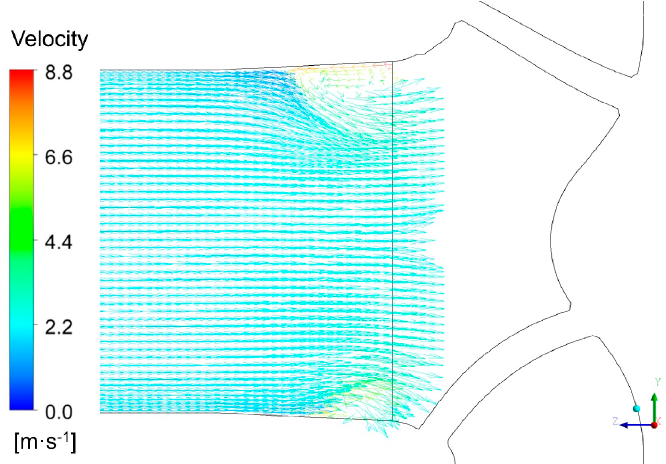
Figure 14. Flow pattern on the midsection of the suction pipe at 0.5 × Q 0 operating condition.